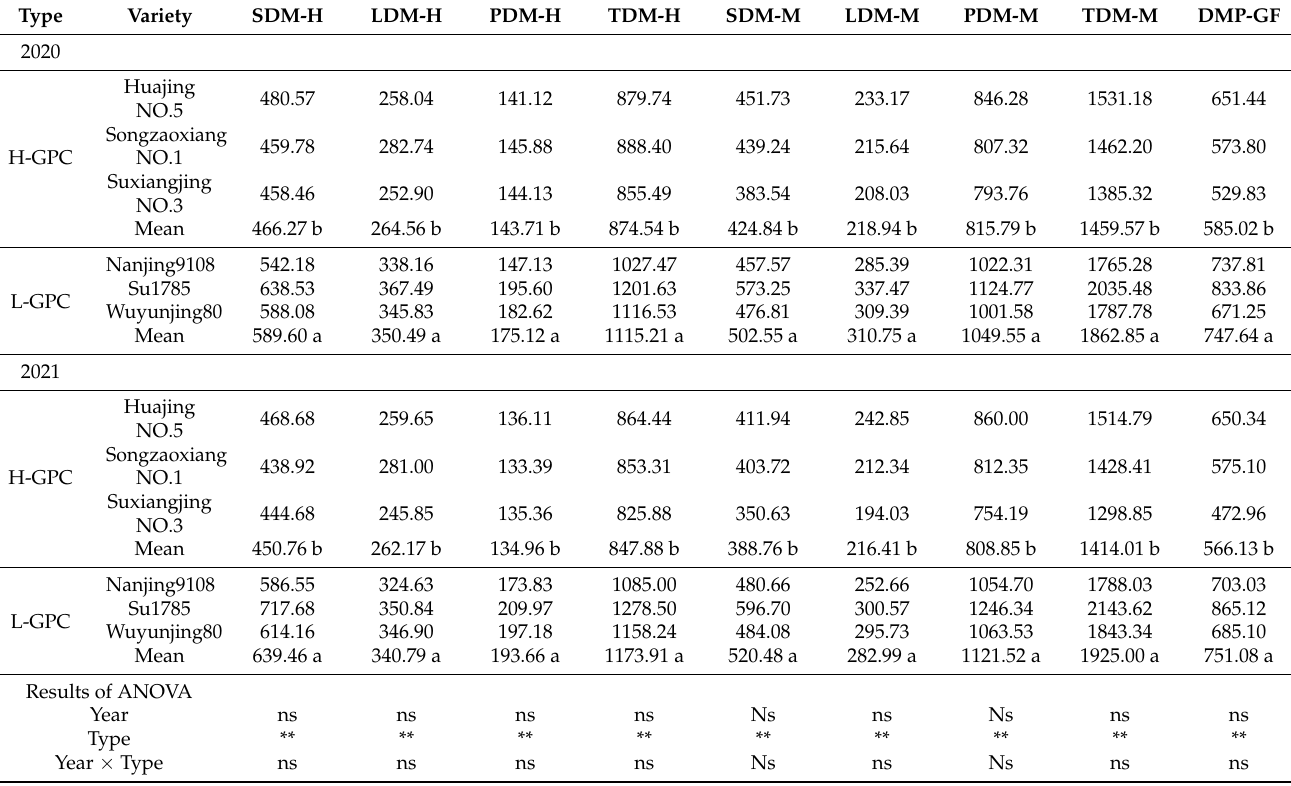
Table 3. Dry matter production at heading stage and maturity (g/m 2 ).